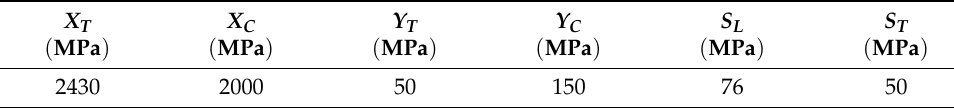
Table 3. Strength properties of S2 Glass/FM 94 epoxy